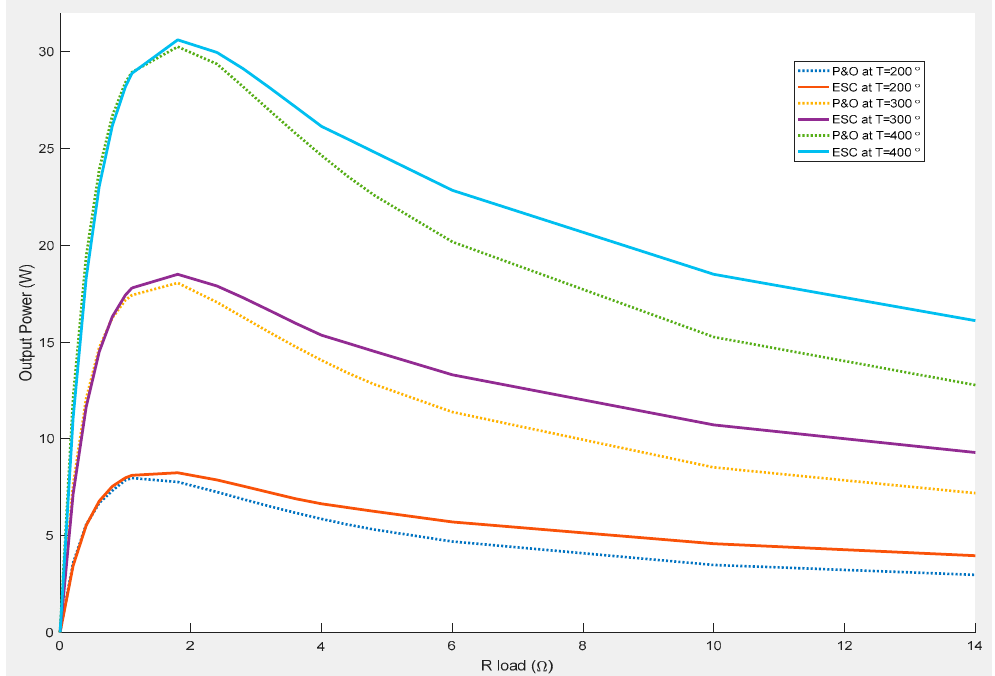
Figure 16. The comparison of output power of ESC and P&O based models.